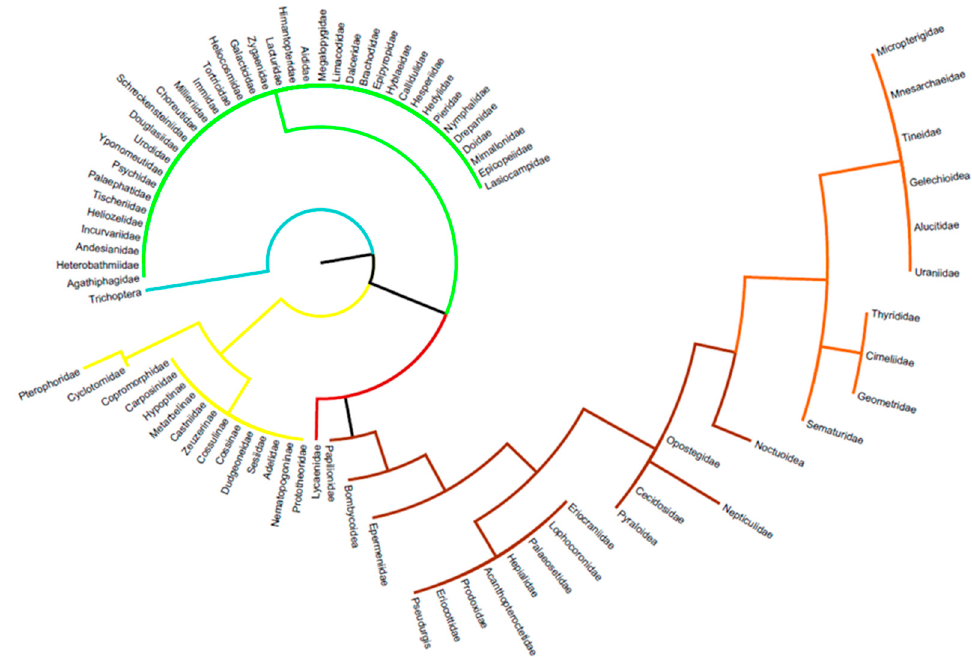
Figure 4. Chrysalis; cladistic classification (see material and methods for parameters) and grouping of subdivisions of the phylogeny of [37] according to the occupation of various living environments. Green: leaf use, yellow: stems or wood, orange: litter, brown: soil, red: pupation in ant hills, and blue: freshwater.